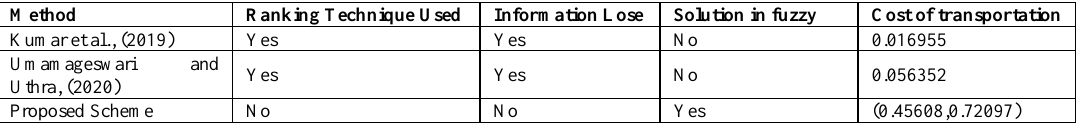
Table 10. Comparison based on optimal transportation cost for example